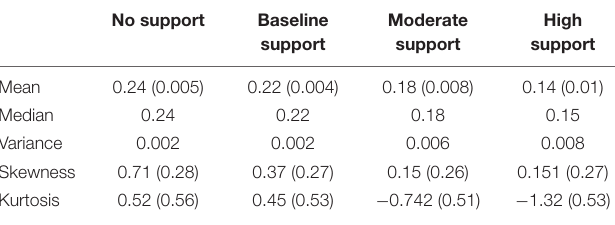
TABLE 4 | Brier Score descriptive statistics (standard error in